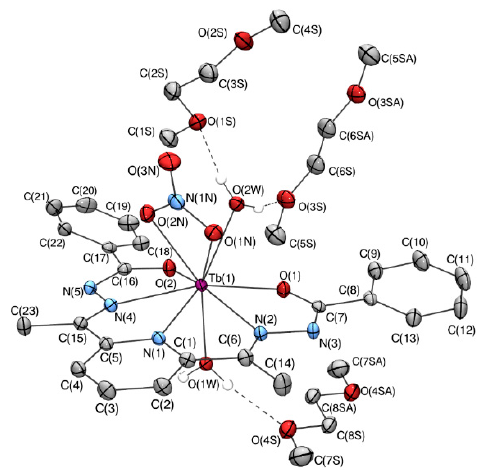
Figure 1. ORTEP [58] drawing of [Tb(DAPBH)(NO 3 )(H 2 O) 2 ](DME) 2 ( 5-Tb ) with the atom numbering scheme. Thermal ellipsoids are shown at the 35% probability level. Hydrogens are omitted for clarity, except those participating in H-bonding.